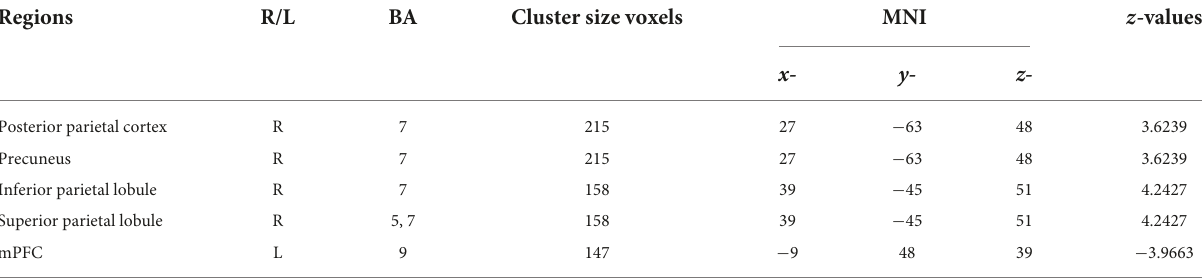
TABLE 2 The brain regions with significant functional connectivity between groups.